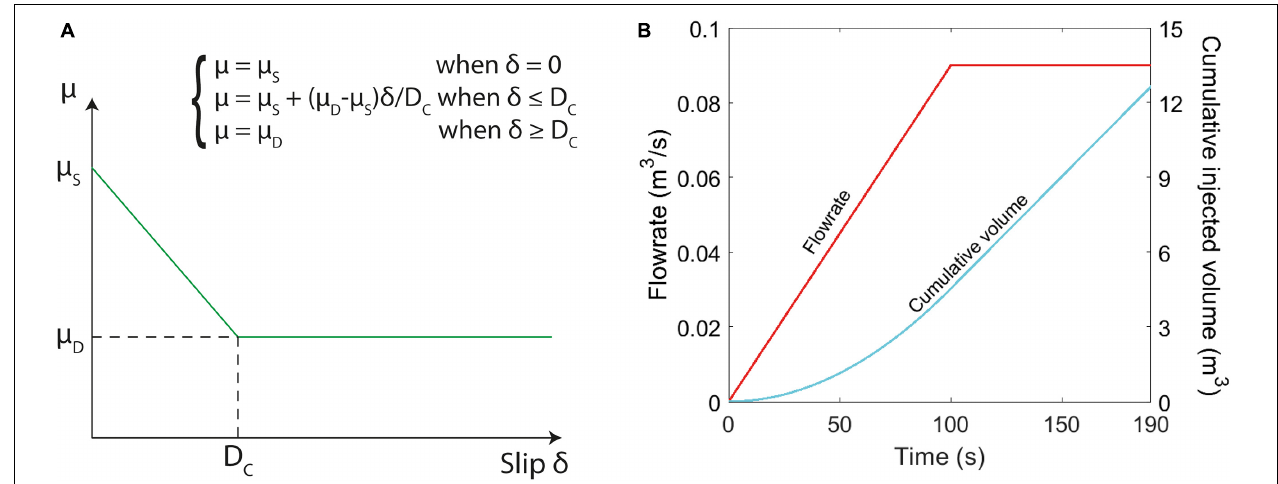
FIGURE 2 | (A) Linear slip-weakening friction with slip ( δ ), static friction coefficient ( µ S ), dynamic friction coefficient ( µ D ), and critical slip distance (D c ). (B) Cumulative injected fluid volume and flowrate vs. time applied at injection in the